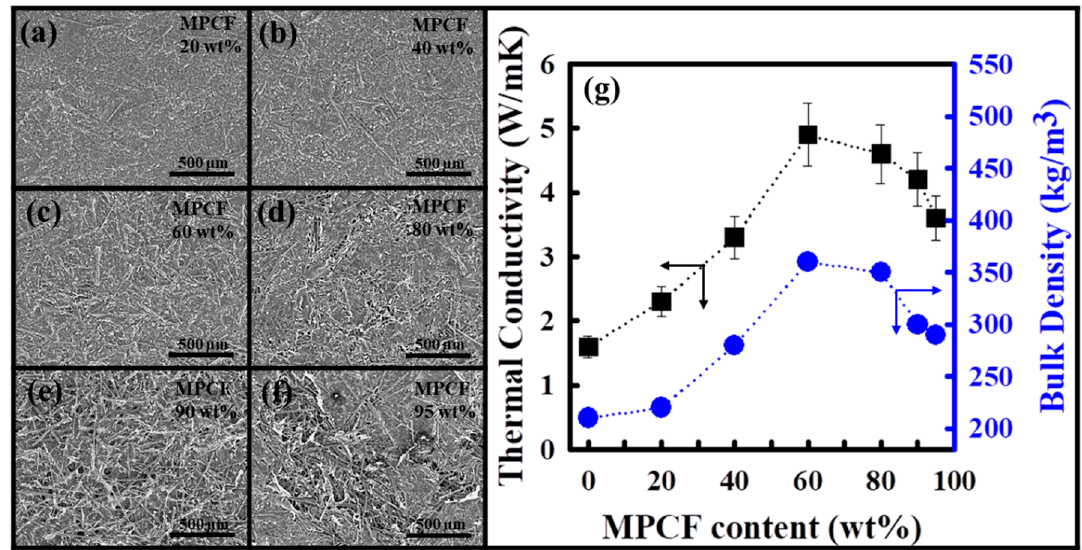
Figure 3. HR-SEM images of the FWCNT-MPCF hybrid films with different mesophase pitch-based carbon fiber (MPCF) (length: 200 µ m) contents: ( a ) 20 wt %, ( b ) 40 wt %, ( c ) 60 wt %, ( d ) 80 wt %, ( e ) 90 wt %, and ( f ) 95 wt %; ( g ) thermal conductivity (black quadrangles and arrows) and film bulk density (blue circles and arrows) of the FWCNT-MPCF hybrid films with different MPCF (length: 200 µ m) contents. These FWCNT-MPCF films were prepared by vacuum filtration following